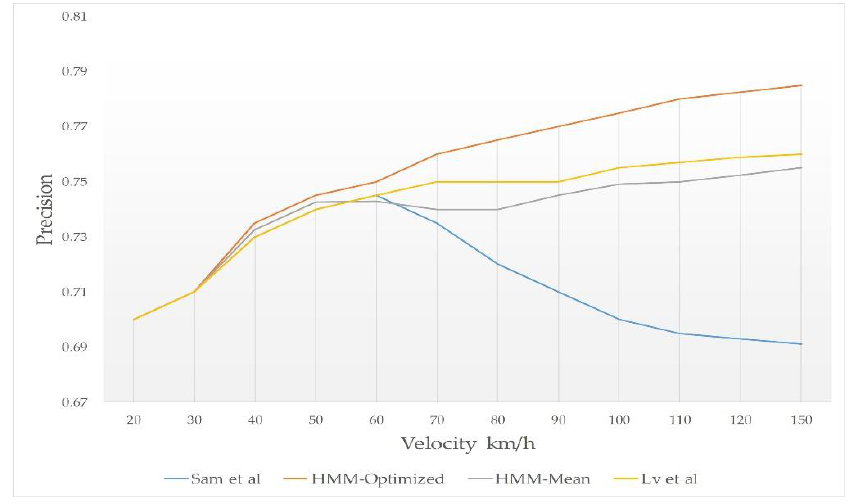
Figure 8. Velocity versus Precision. Information 2018 , 9 , x FOR PEER REVIEW